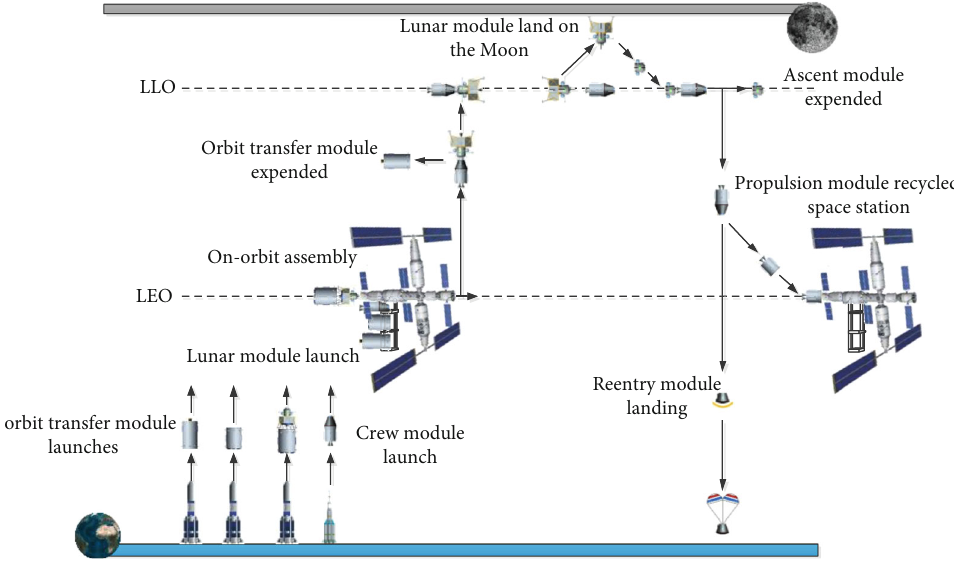
Figure 1: The lunar mission architecture employing a space station in LEO.